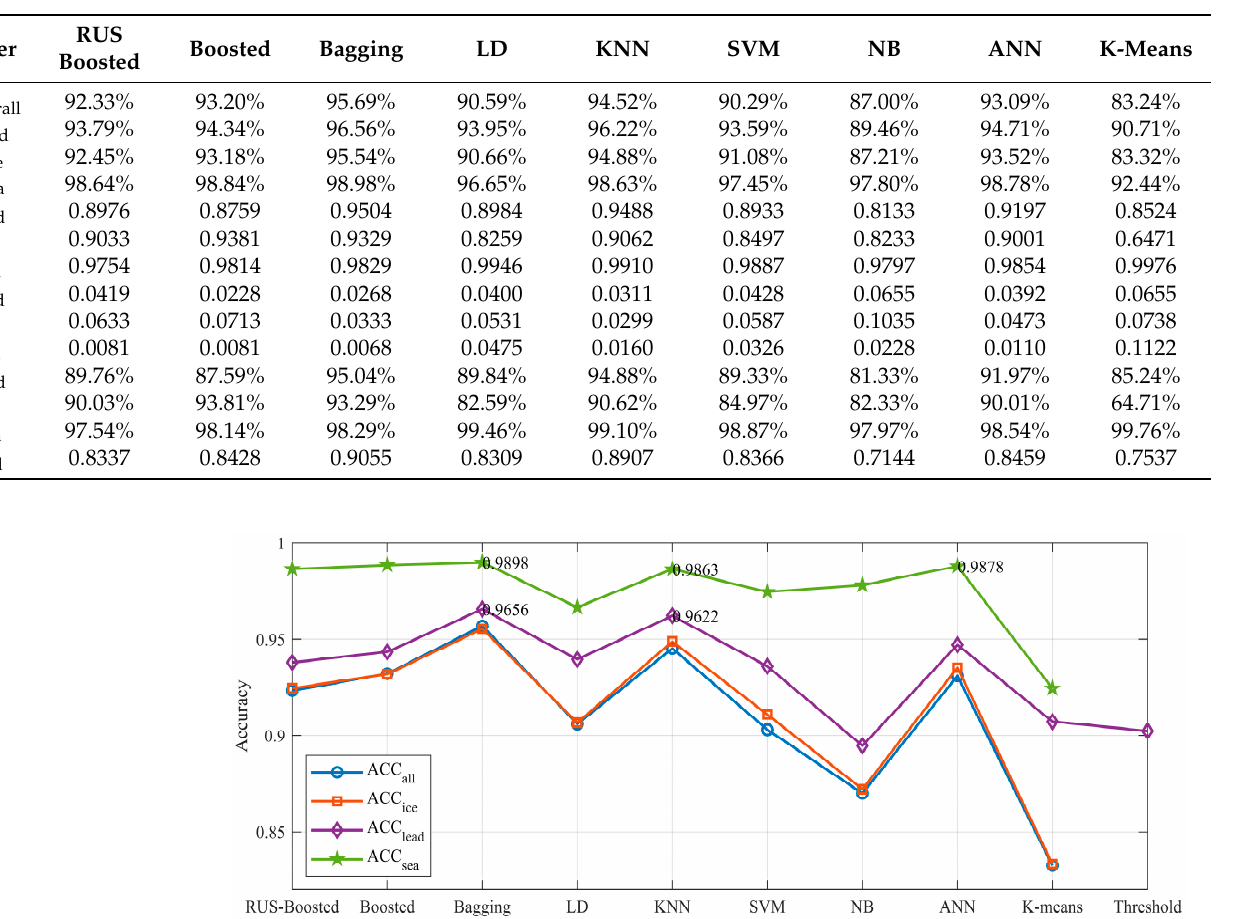
Table 2. Results of classification performance metrics for supervised and unsupervised learners.